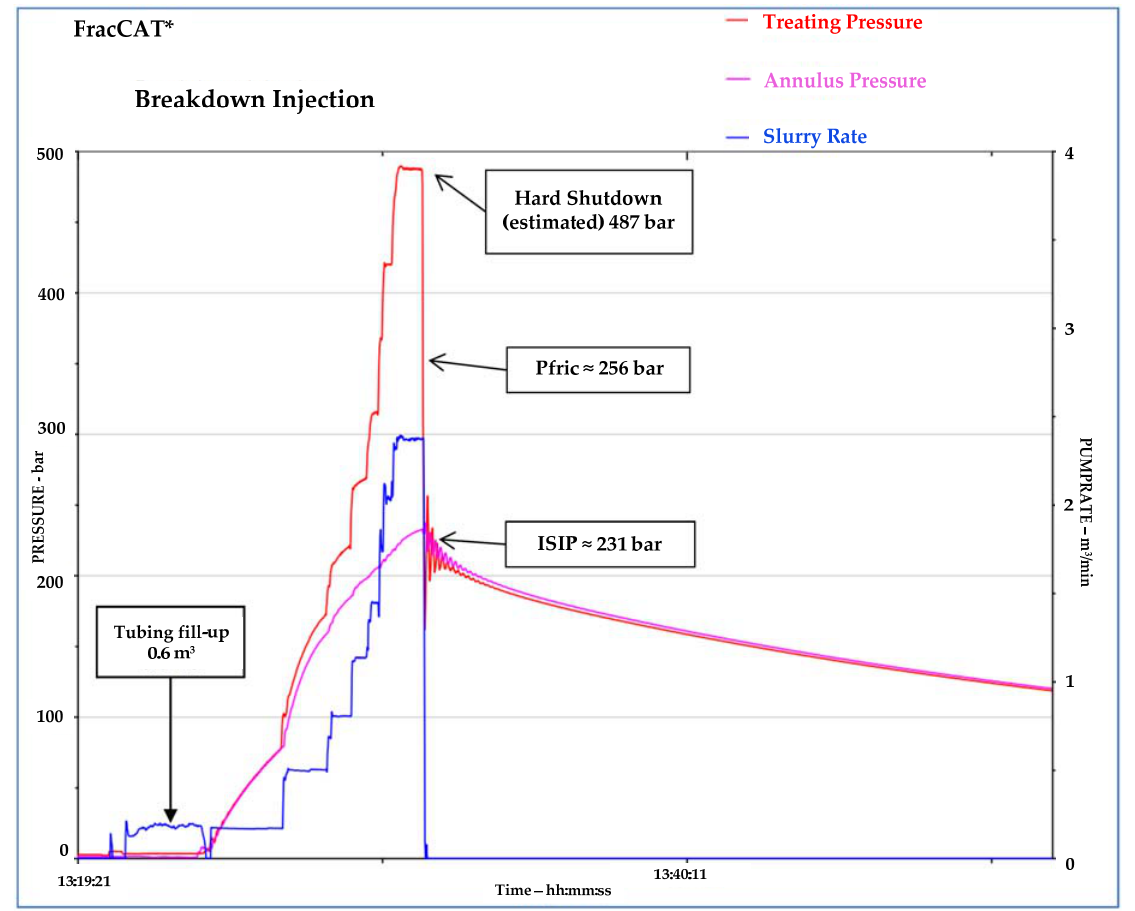
Figure 5. Breakdown injection test diagram [3]. ISIP: instantaneous shut-in pressure; Pfric: total friction.